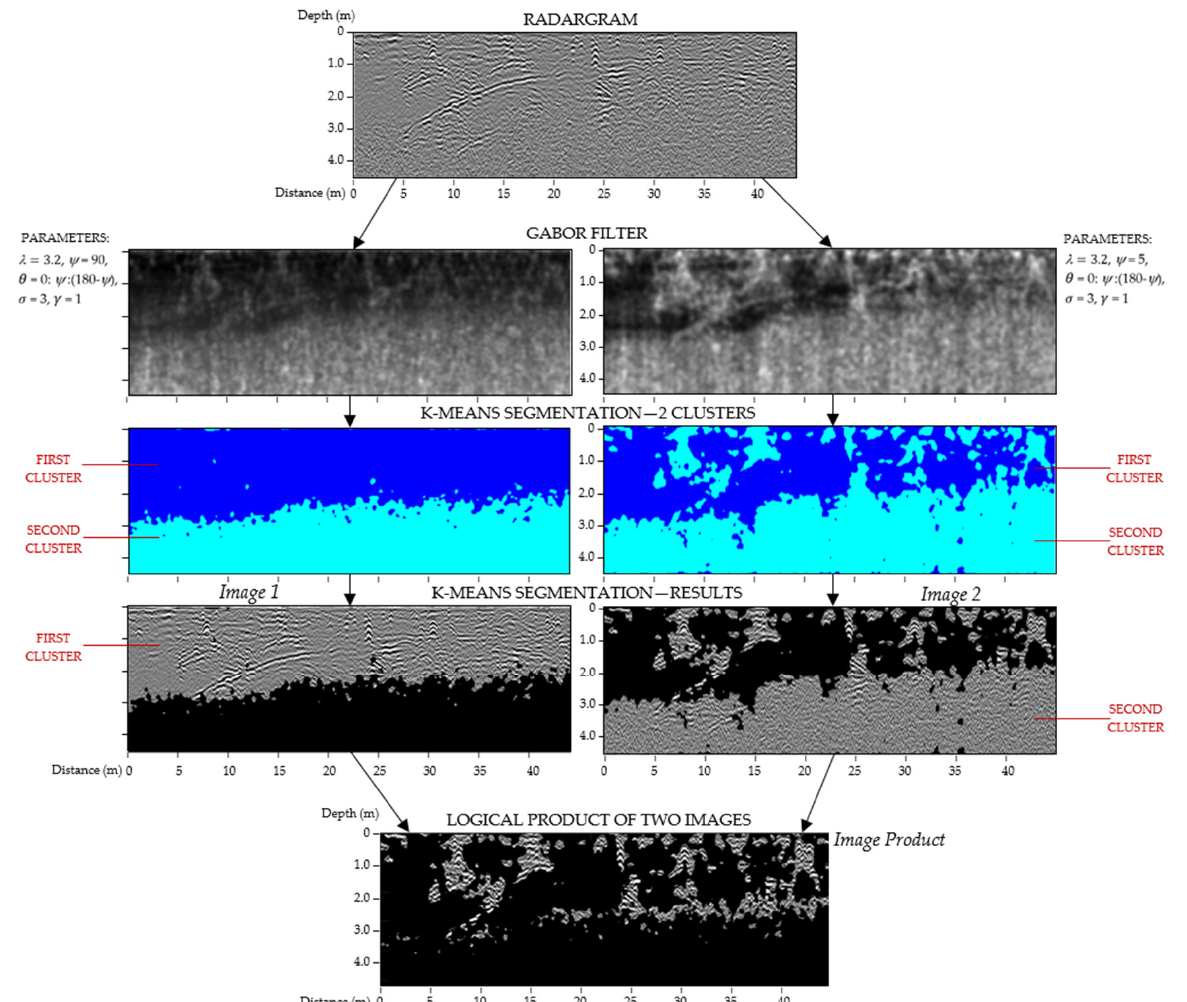
Figure 10. Result of k-means clustering of a sample image after Gabor filtration.